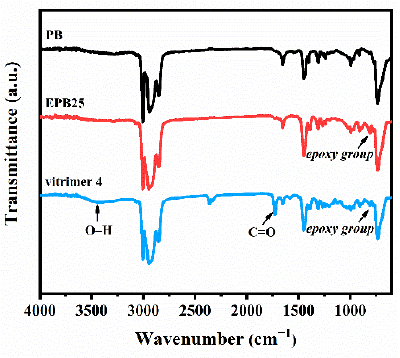
Figure 1. FT-IR spectra of PB, EPB25, and vitrimer 4.